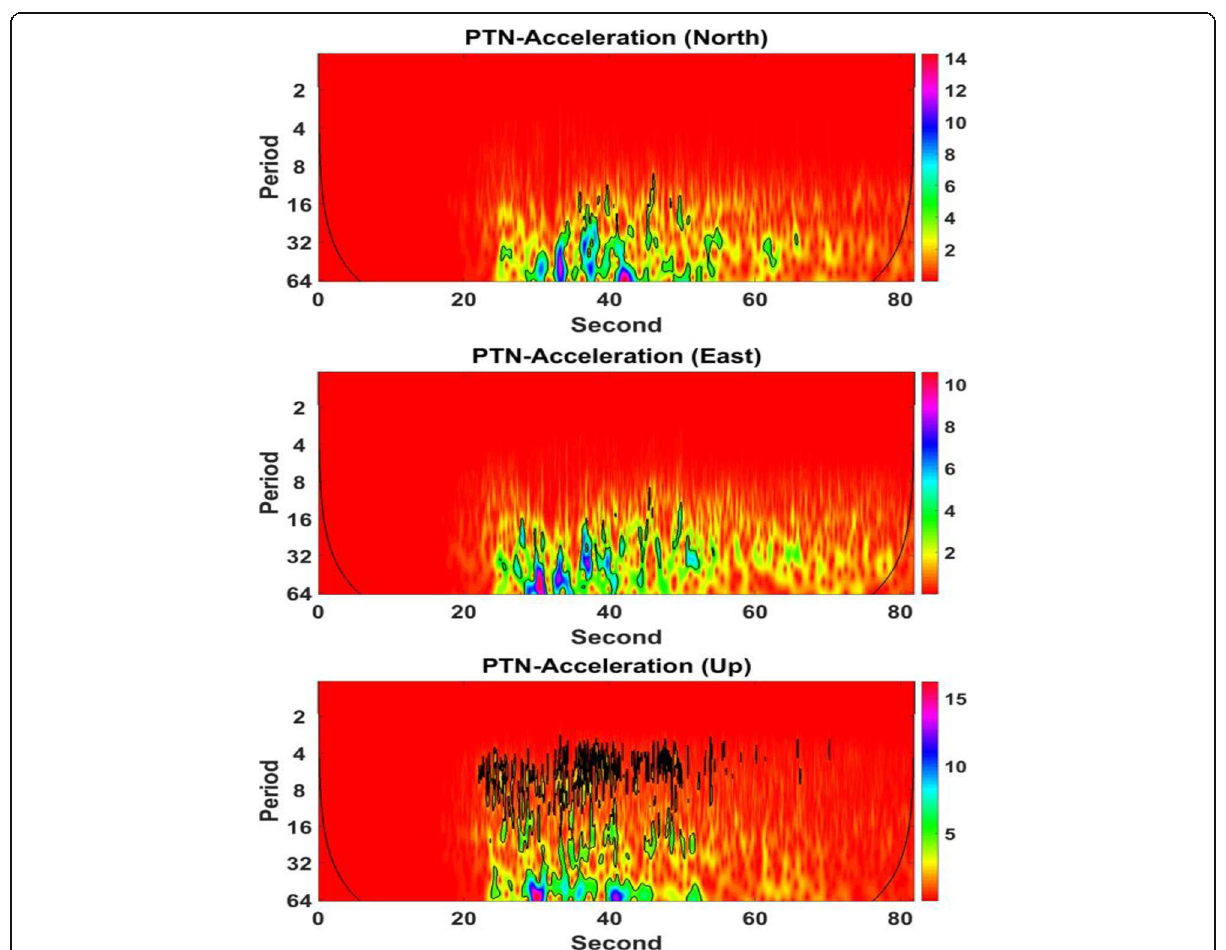
Fig. 11 Two Dimension CWT-Scalogram ground motion from NS, EW, and Vertical record (0 – 80 s) at PTN